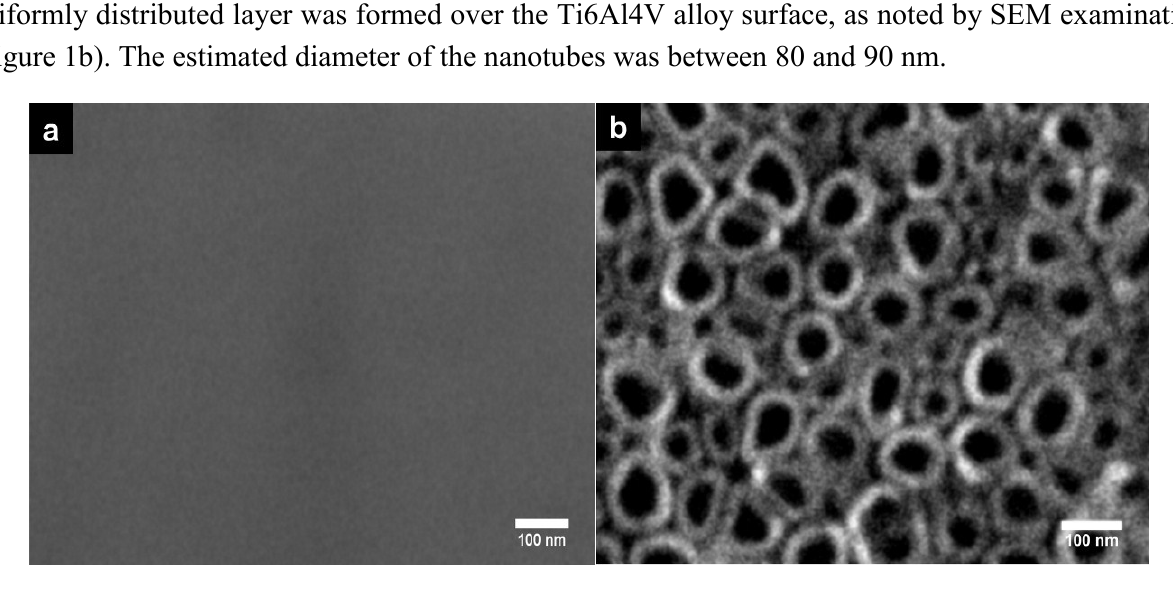
Figure 1. SEM micrographs of the experimental Ti6Al4V alloys. ( a ) Non-anodized flat Ti6Al4V alloy; ( b ) anodized Ti6Al4V alloy with